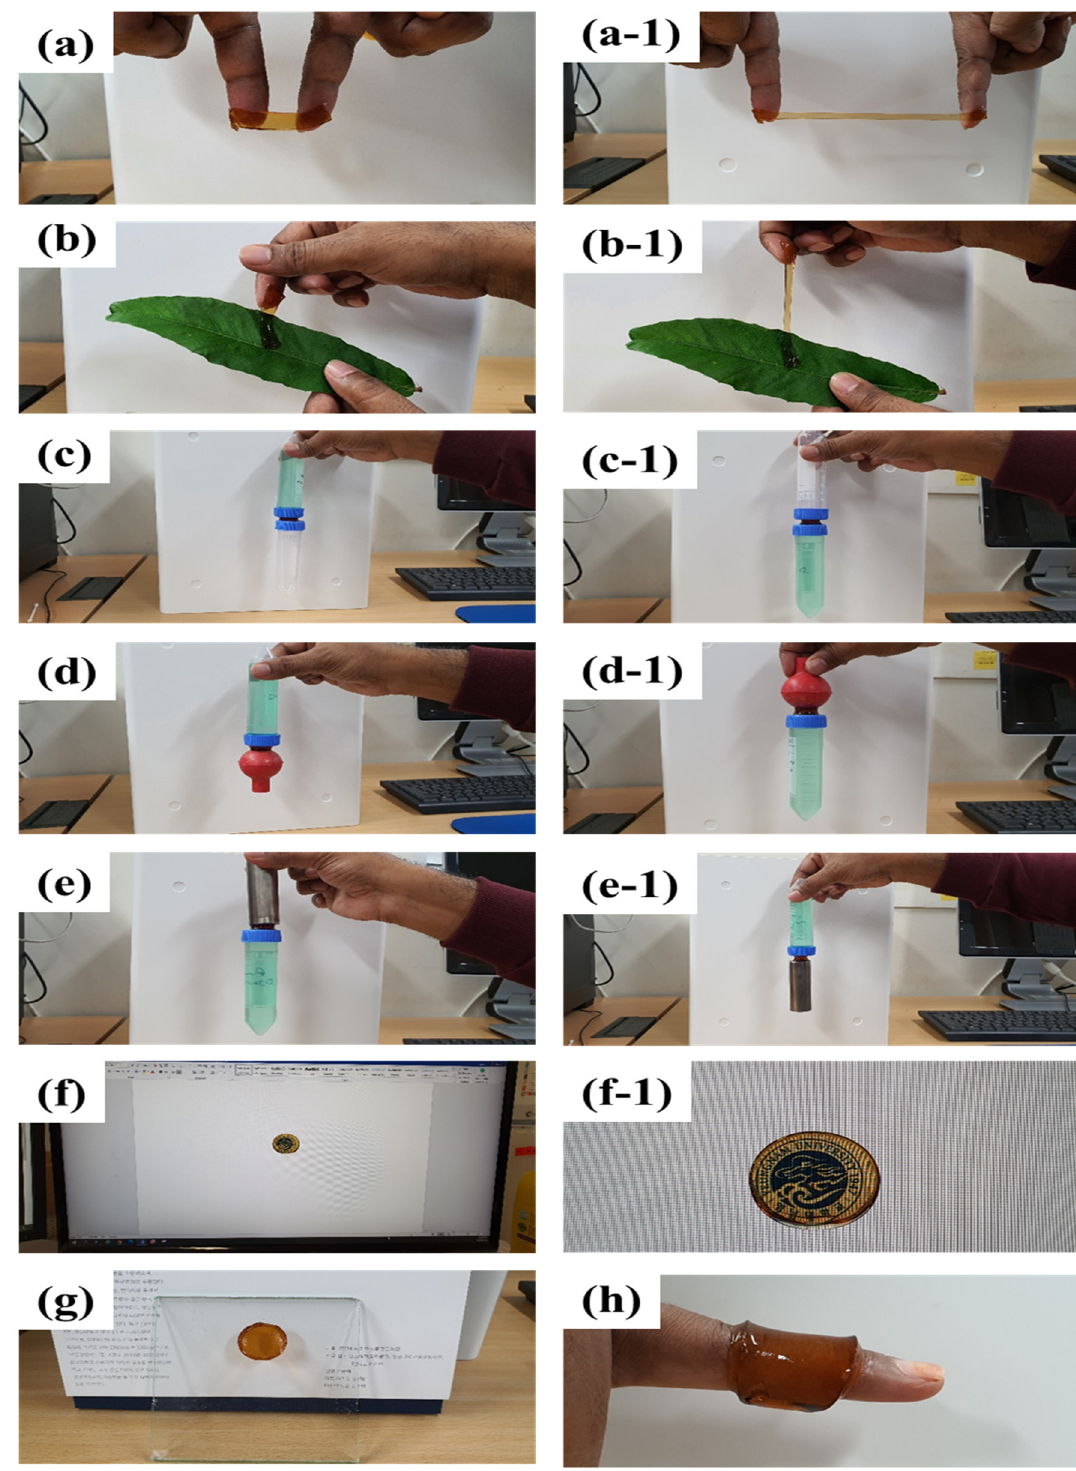
Figure 1. The 0.4DA-FCMCS hydrogel adhesion for ( a ) fingers and ( a-1 ) its stretchable condition, ( b ) leaf and its stretchability ( b-1 ), ( c ) 100 g plastic tube and plastic tube, ( c-1 ) plastic tube and 100 g plastic tube, ( d ) plastic tube and rubber, ( d-1 ) rubber and 100 g plastic tube, ( e ) steel and 80 g plastic tube, ( e-1 ) 100 g plastic tube and 100 g of steel, ( f ) computer screen, ( f-1 ) transparency of hydrogel on computer screen, ( g ) glass plate, and ( h ) foldable to author’s finger.